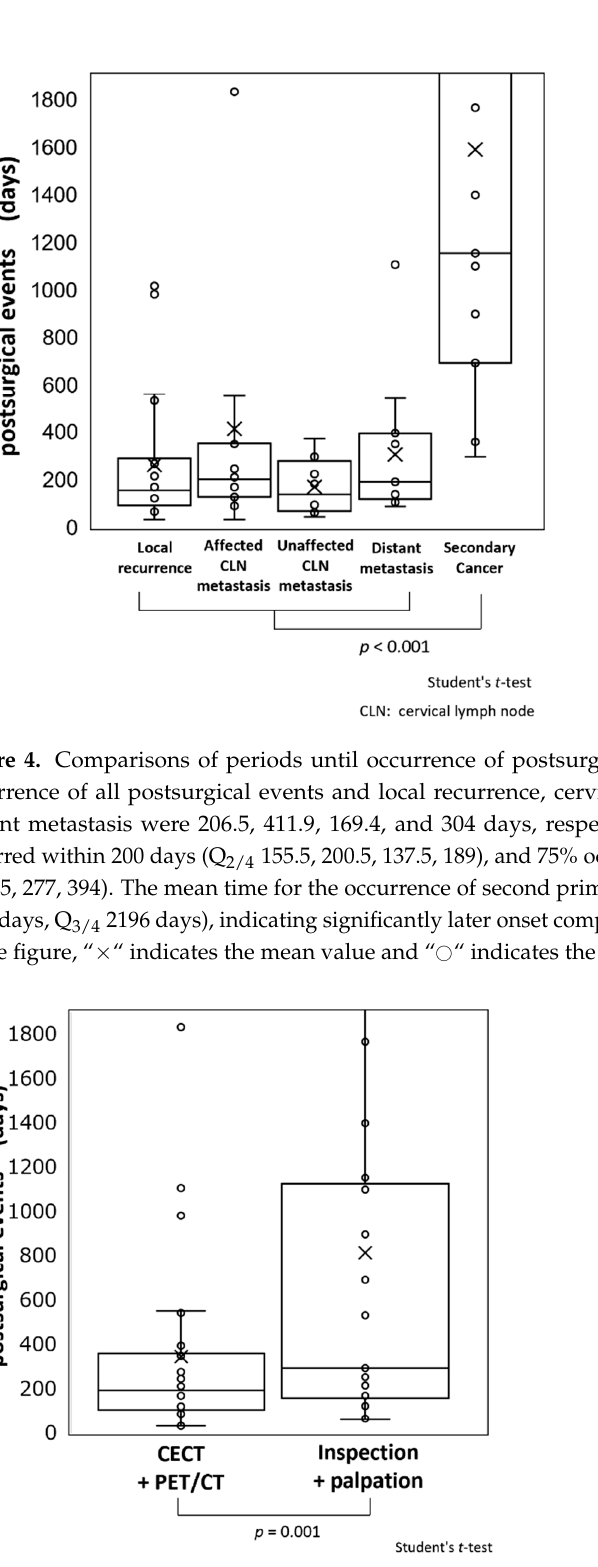
Figure 5. Comparisons of periods until occurrence of postsurgical events based on detection method. The mean times of occurrence of postsurgical events were 345.1 days (Q 2/4 190.5 days, Q 3/4 359.3 days) for those detected by FDG-PET/CT and CT and 839.3 days (Q 2/4 294 days, Q 3/4 1139.5 days) for those detected by visual examination and palpation. Thus, events detected visually and by palpation had significantly later onset compared with those detected by imaging ( p = 0.001). In the figure, “ × “ indicates the mean value and “ ○ “ indicates the event occurrence per patient.